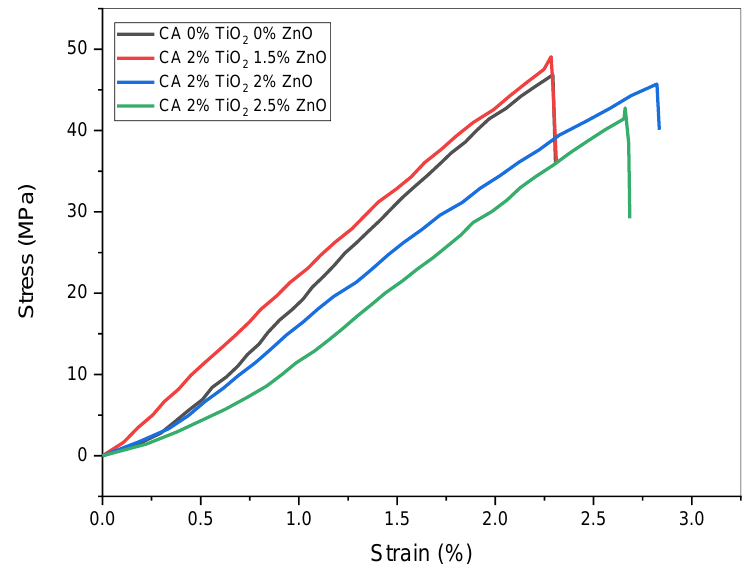
Figure 3: The stress-strain curve of ZnO/TiO 2 with Cellulose acetate.